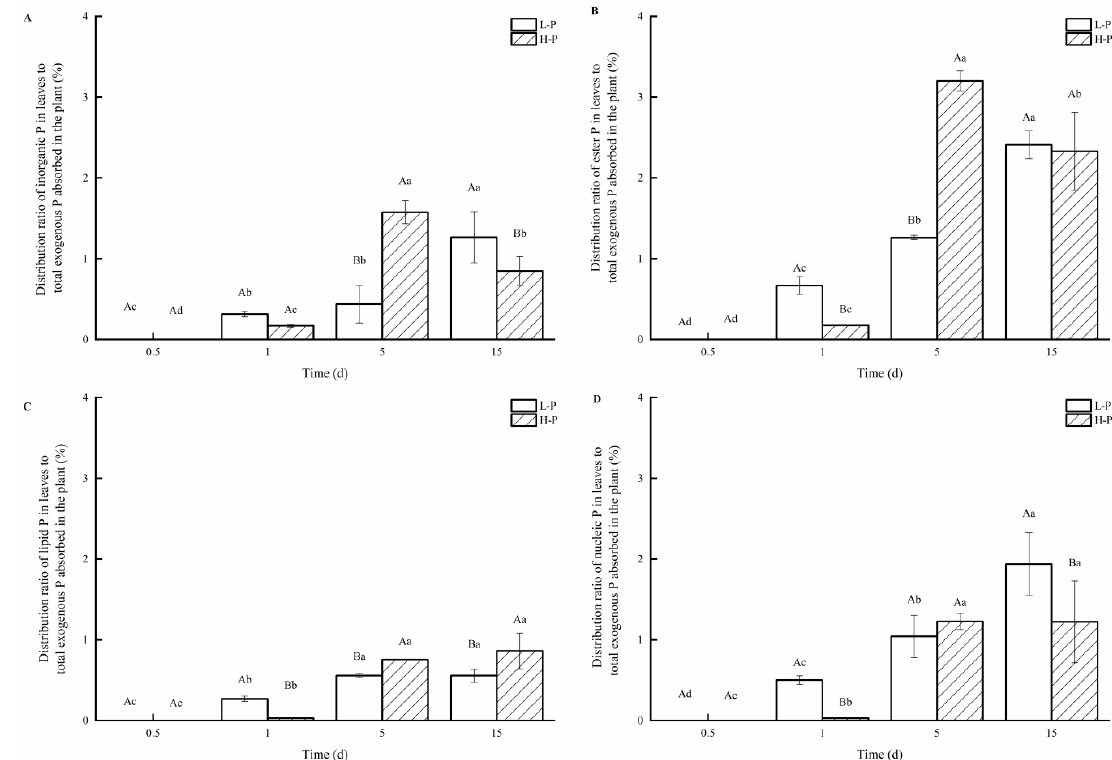
Figure 4. Percentage of different P fractions in leaves to total exogenous P absorbed in the plant under high- and low-P treatments: ( A ) inorganic P, ( B ) ester P, ( C ) lipid P, and ( D ) nucleic P. “L-P” and “H-P” represent the low-P and high-P treatments, respectively. Error bars represent standard error, and each point in the figures represents the mean of the five replicates ( n = 5). Lowercase letters indicate significant differences ( p < 0.05) at different treatment times under the same P treat- ment. Uppercase letters indicate significant differences ( p < 0.05) between different treatments at each time point.